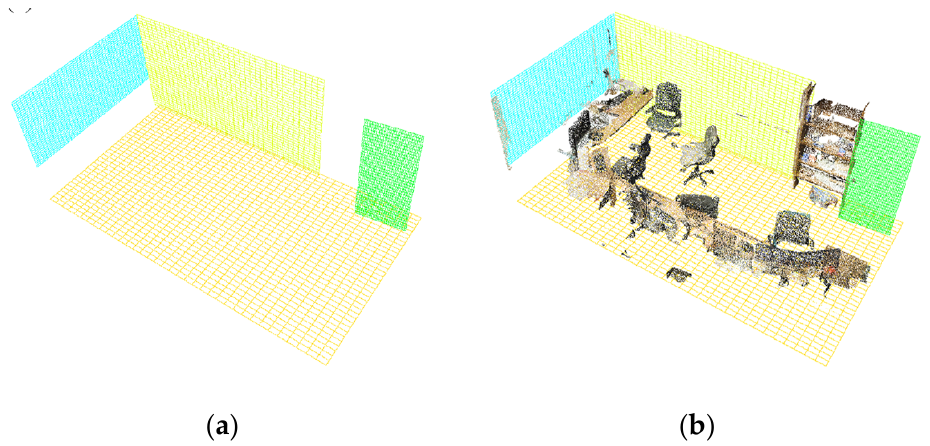
Figure 2. An example of robust structural plane extraction: ( a ) the extracted structural planes in the indoor scene, ( b ) the extracted structural planes and the remaining point clouds of the scene.